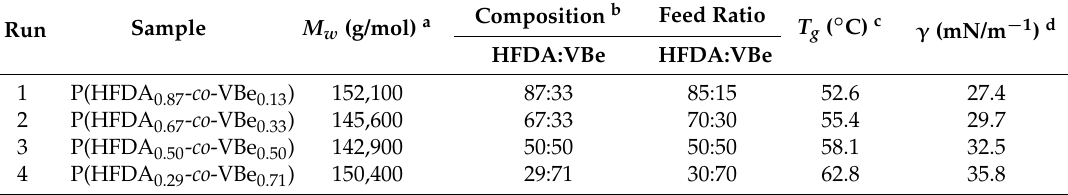
Table 2. Experimental results for the synthesis and physical properties of the